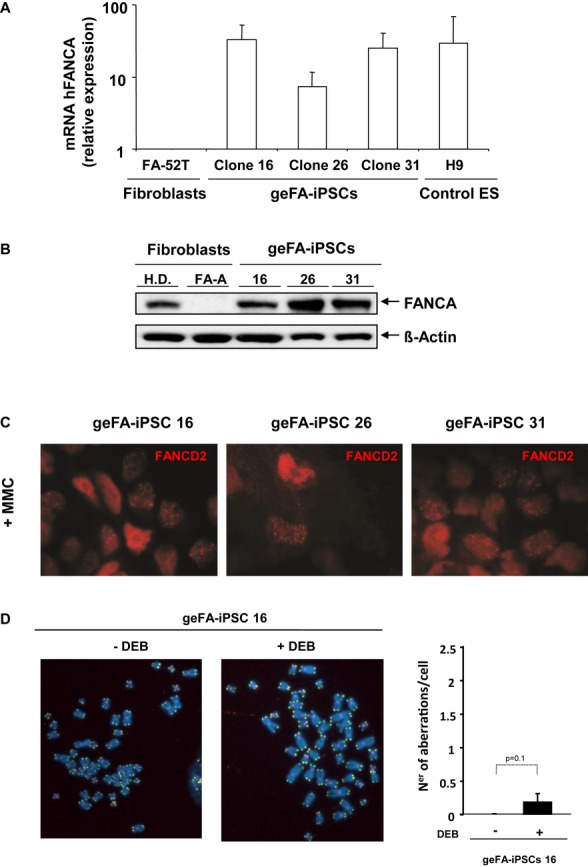
Disease-free Fanconi anemia phenotype of corrected geFA-iPSCsHistogram showing the levels of hFANCA expression in gene-edited FA-iPSC clones and human ES (H9) relative to untreated FA-52T fibroblasts. Data are shown as mean ± s.e. of three different analyses.Western blot analysis showing FANCA expression in geFA-iPSC clones in comparison with fibroblasts from HD and a FA-A patient.Representative immunofluorescence analysis of FANCD2 foci in geFA-iPSCs after DNA damage with mitomycin C (MMC).Chromosomal instability induced by diepoxybutane (DEB) was also tested in geFA-iPSC 16. FISH analysis was performed using probes to detect telomeres (green), centromeres (pink) and chromosomes (blue). Right: histogram showing the number of chromosomal aberrations per cell.Data information: Data are shown as mean ± s.e. from three different experiments (A) or analysis of twenty different metaphases per group (D). All P-values were calculated using two-tailed unpaired Student's t-test.